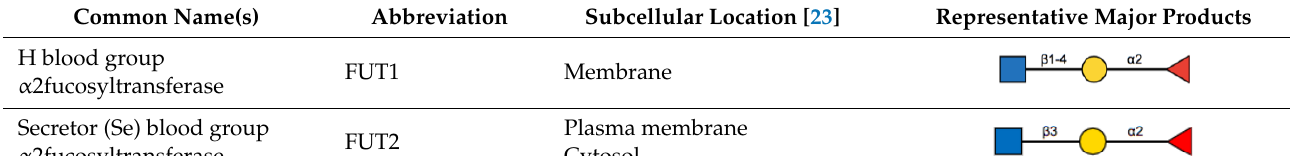
Table 1. Known fucosyltransferases in Humans. Adapted from [18,21] and created with GlycoGlyph [22].